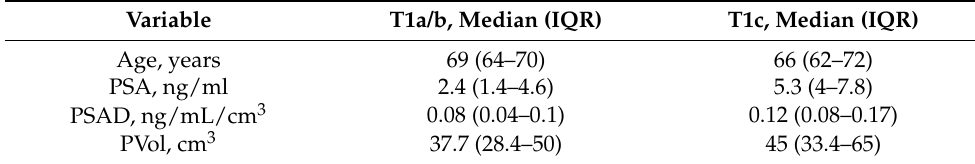
Table 2. Patient characteristics at inclusion, T1a/b versus